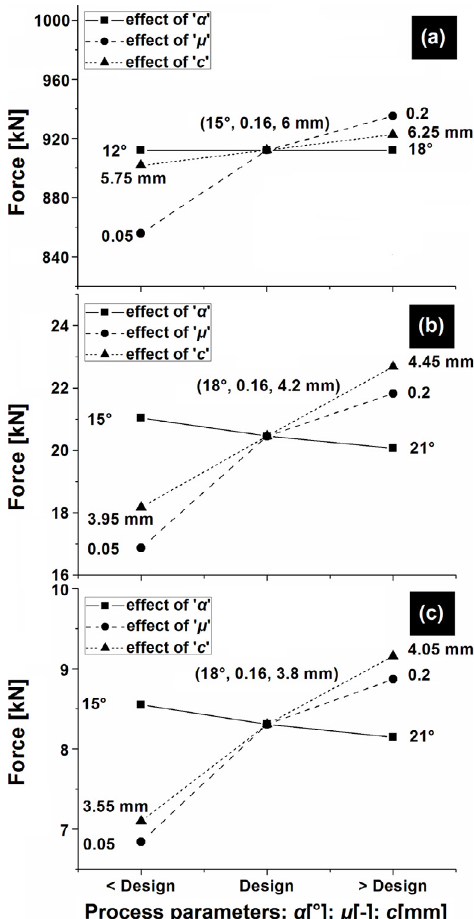
Figure 6. Graphical showing of influences of process parameters ( α; μ; c ) on draw punch force, (a) 1 st draw, (b) 2 nd draw, and (b) 3 rd draw.